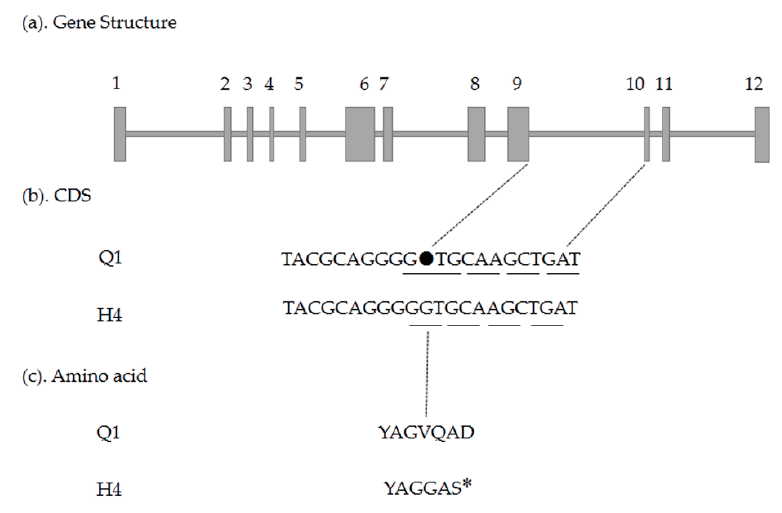
Figure 8. Comparison analysis of the cDNA sequence of Csa3G904140 gene between Q1 and H4; the insertion lead to a premature stop codon: ( a ) gene structure of Csa3G904140 , including 12 exons and 11 introns; ( b ) coding sequence analysis of a single-nucleotide insertion; ( c ) a frameshift result in a premature stop codon; * delegates the stop of protein translation.